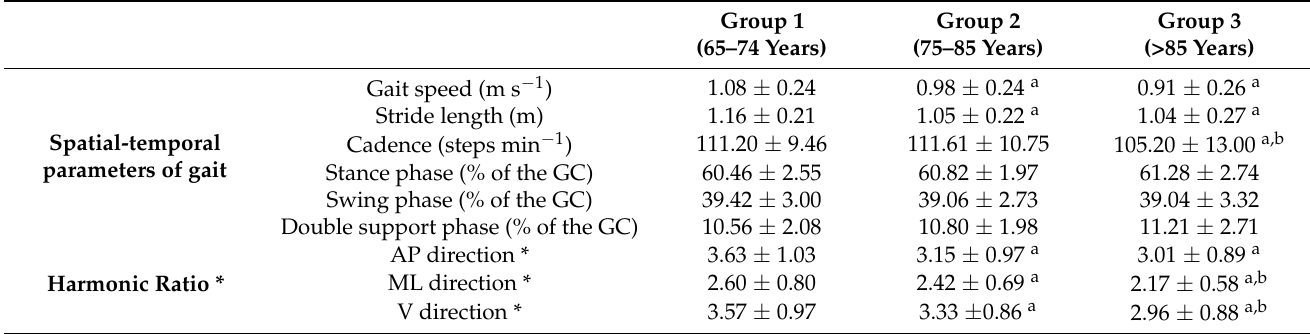
Table 2. Mean and standard deviation values of the spatio-temporal and HR (Harmonic Ratio) parameters in the three considered